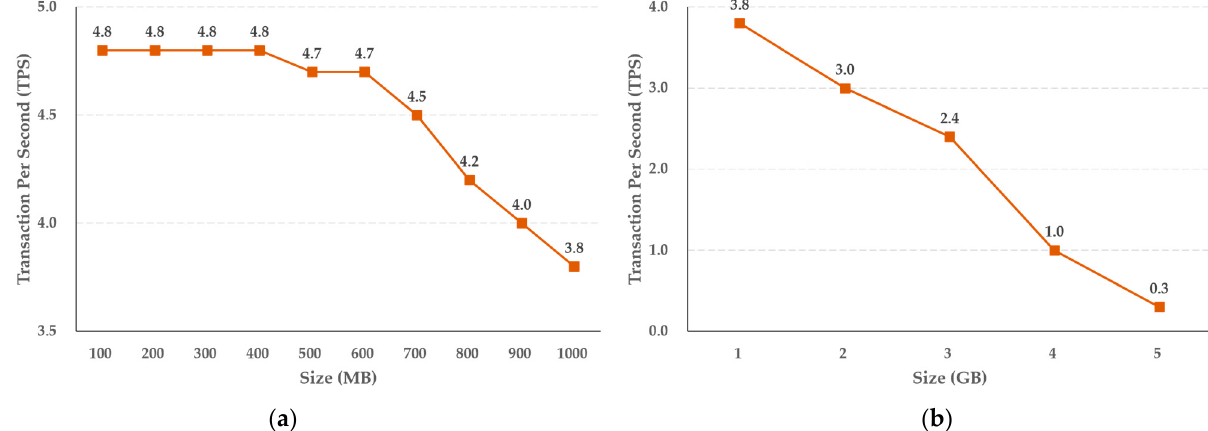
Figure 7. Results of crime evidence video storing performance ( a ) per MB, and ( b ) per GB in the cold blockchain system.